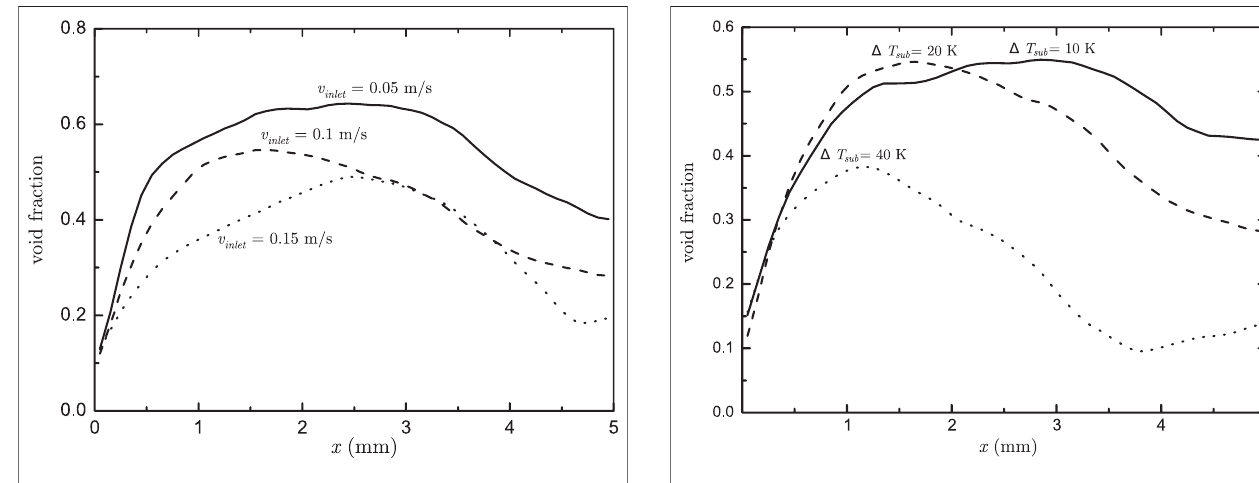
FIGURE 15 | Local pro fi le of void fraction at y (cid:2) 30 mm under various inlet velocities.